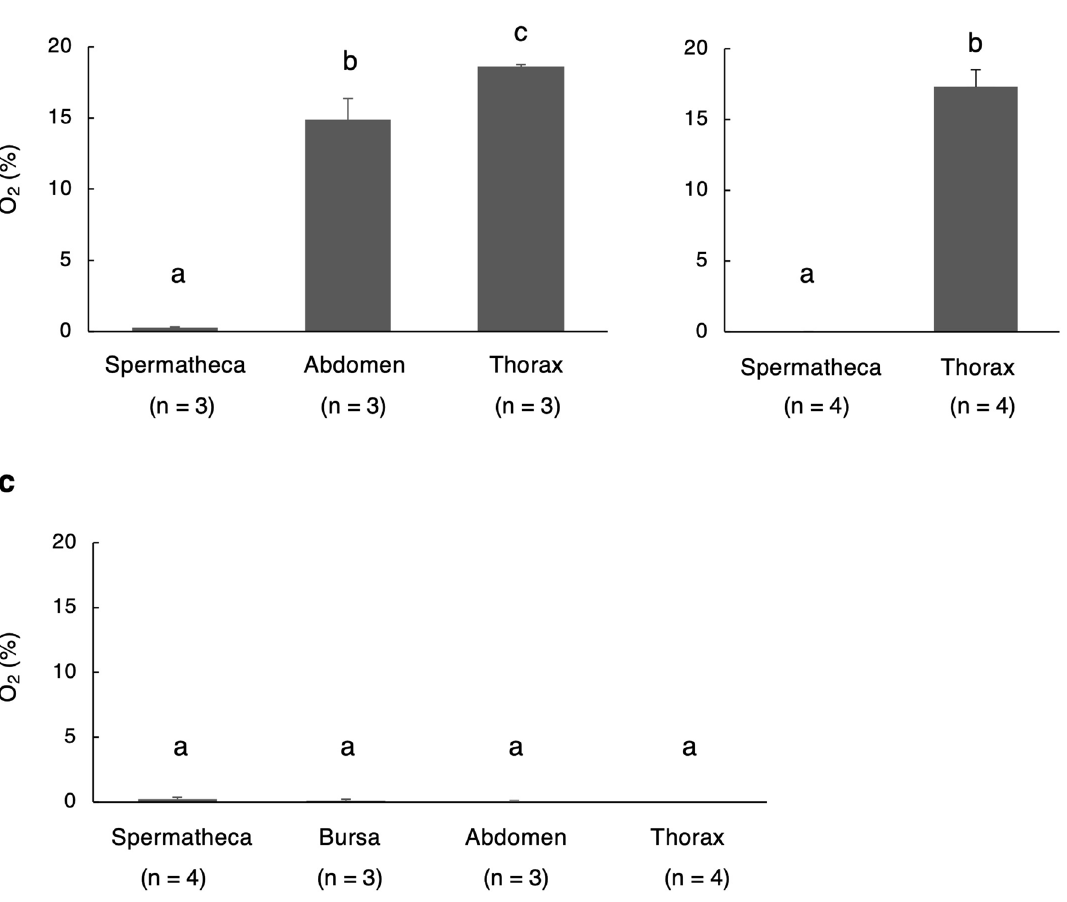
Figure 1. Tissue oxygen concentration in ( a ) Crematogaster osakensis queens at 1 year, ( b ) Lasius hayashi queens at 7 months after the beginning of sperm storage (or nuptial flight), and ( c ) C . osakensis queens soon after nuptial flight. Error bars represent standard deviation. Different alphabetical symbols indicate statistical significance at p < 0.05 based on Tukey’s post-hoc test in ( a ) and ( c ) and Mann–Whitney U test in ( b